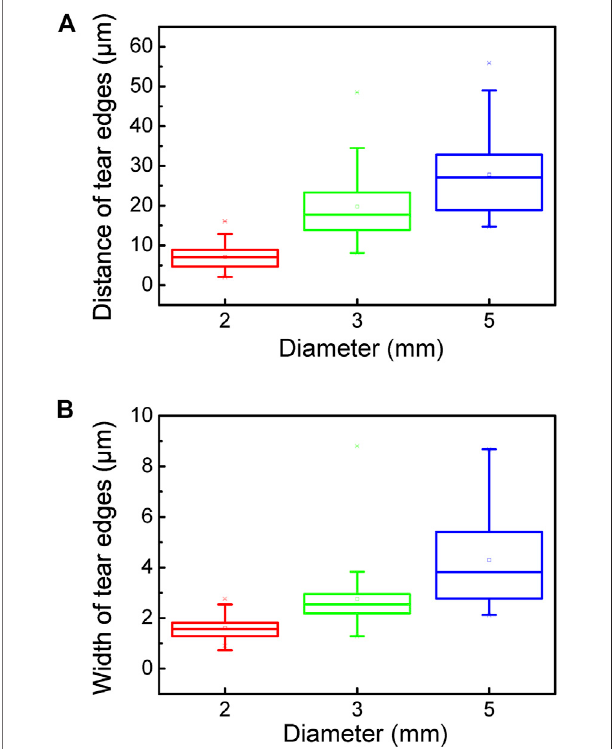
FIGURE4 |(A) thestatistics ofdistancebetween adjacent tear ridges at samples with different diameters; (B) the statistics of width of each tear ridge at samples with different diameters. Note: all the data come from Figure 3